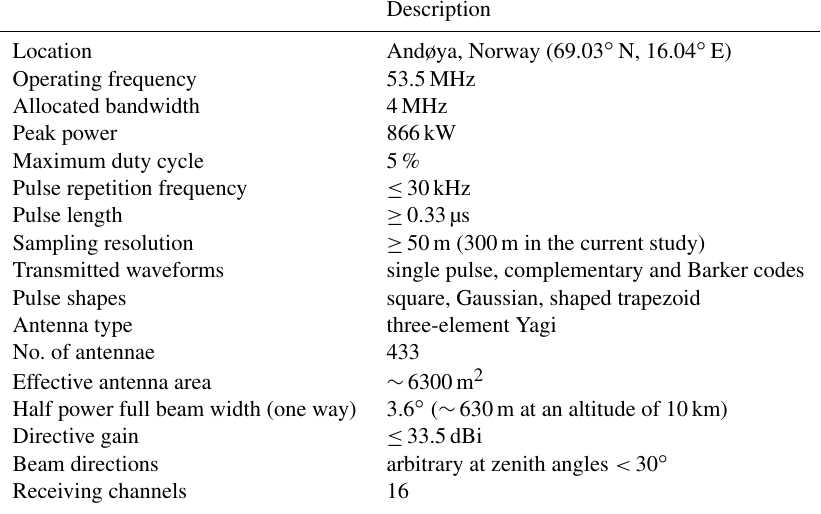
Table 1. Basic parameters of